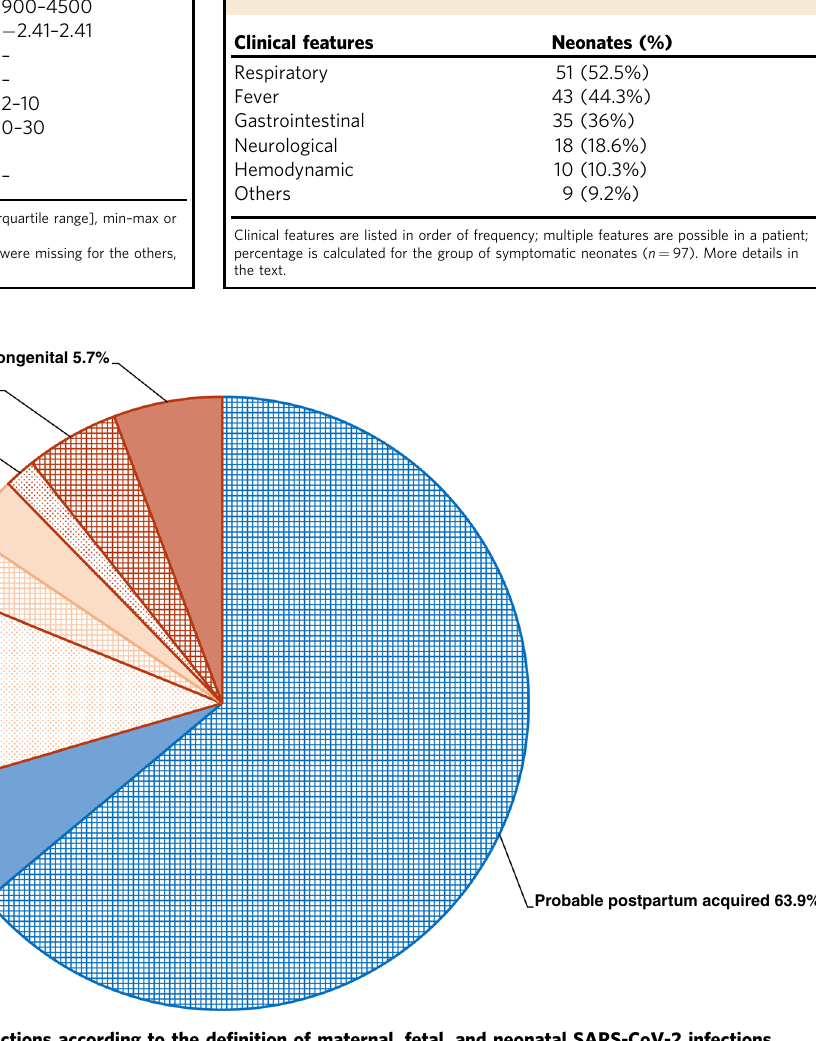
Table 3 Distribution of clinical features in the subgroup of neonates presenting with signs or symptoms compatible with